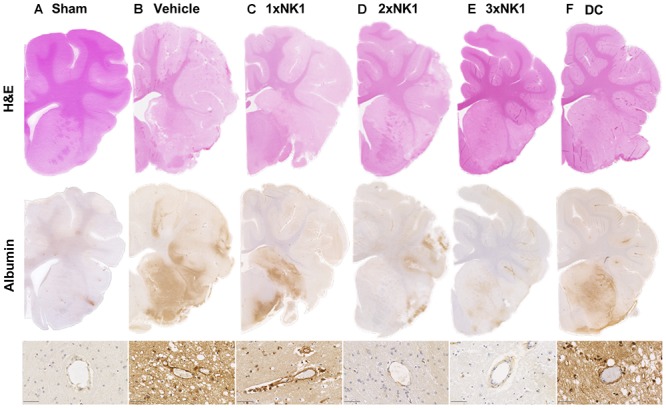
Hematoxylin and Eosin staining and albumin immunoreactivity in (A) sham, (B) vehicle, (C) 1×NK1, (D) 2×NK1, (E) 3×NK1, and (F) DC animals. H&E staining shows evidence of pallor and reduced gray white matter differentiation, which is especially prominent in vehicles and 1×NK1 treated animals. Enhanced albumin extravasation was seen macroscopically in vehicle, 1×NK1 and DC treated animals compared to sham, 2×NK1 and 3×NK1 treatment groups. This pattern of albumin staining is consistent with the perivascular staining seen in microscopic images. Scale bar 50 μm, 40× magnification.